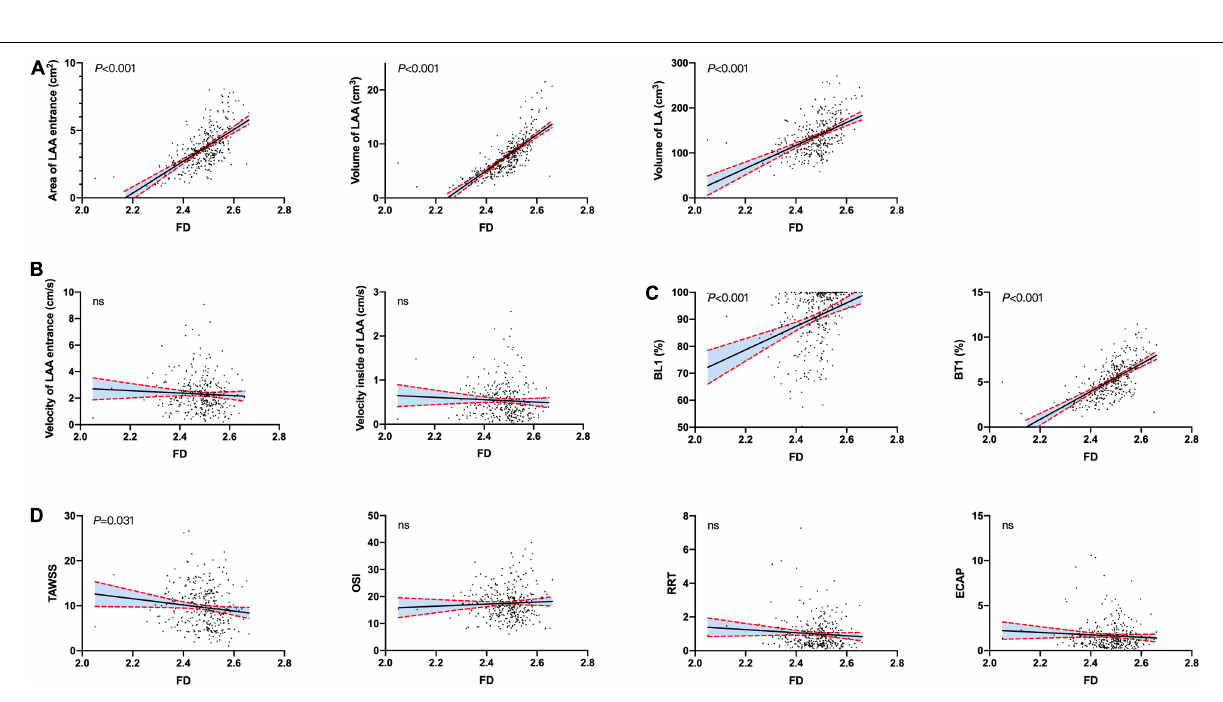
Frontiers in Cardiovascular Medicine |